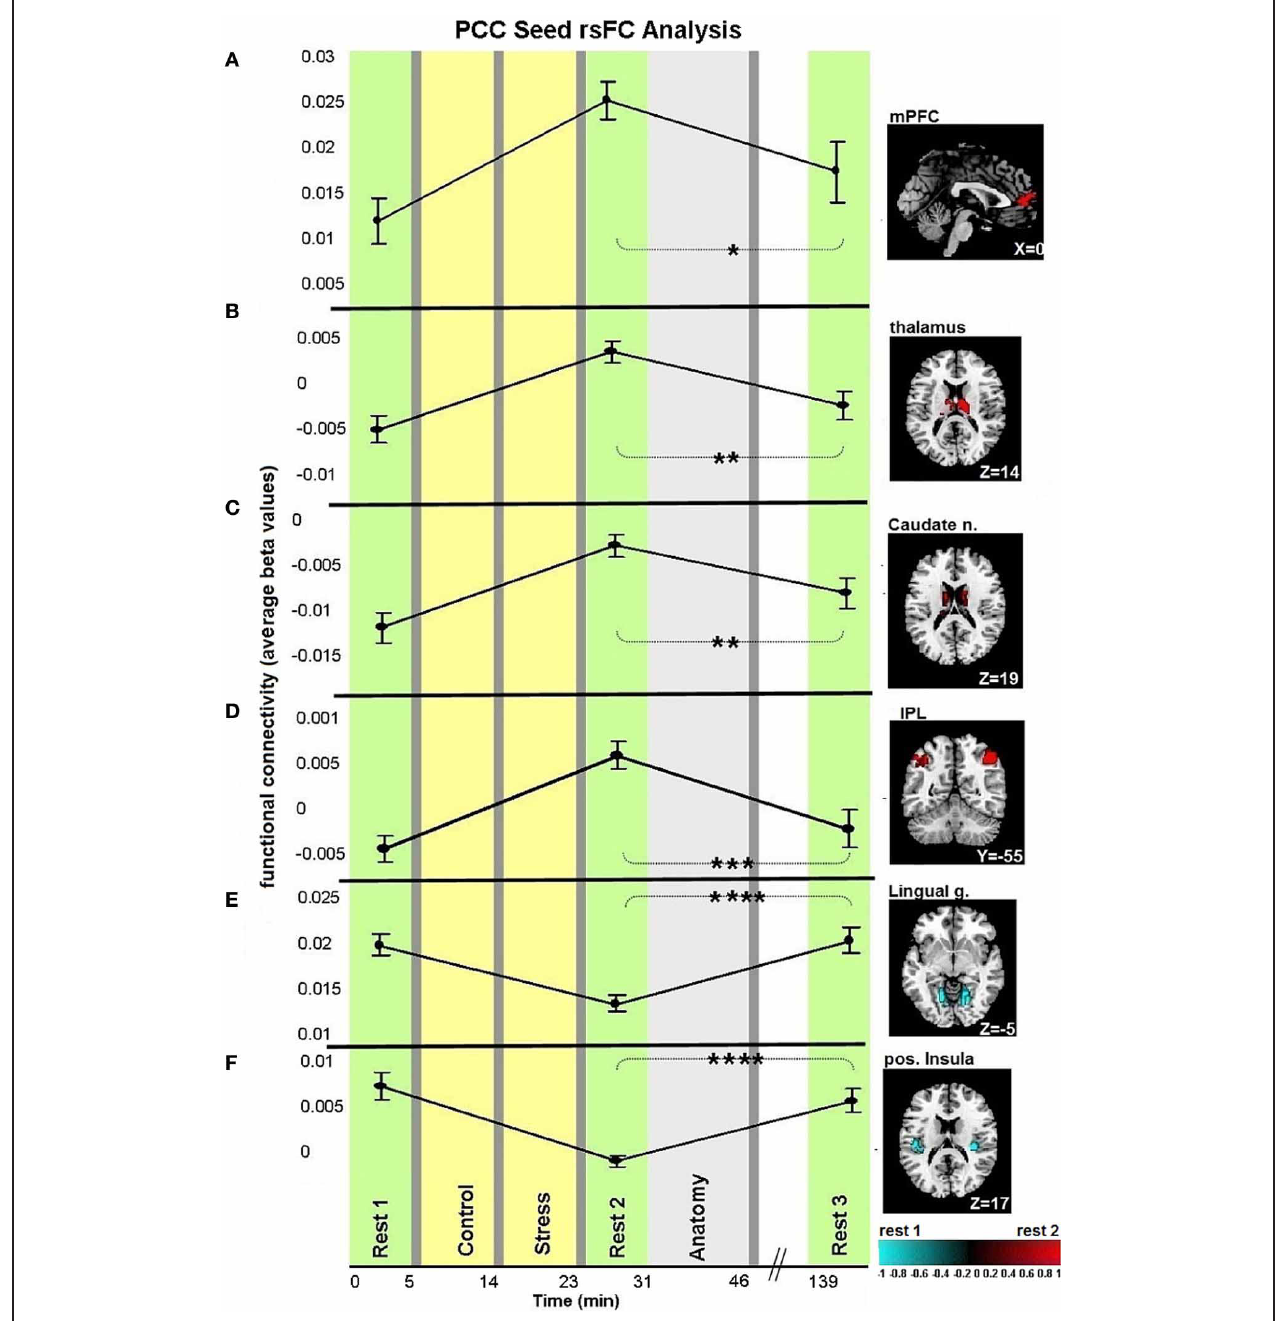
FIGURE 3 | Dynamics in rsFC to the PCC seed ROI in the three “rest” conditions. Localized areas that changed connectivity to the PCC seed (A–F) when contrasting “rest 1” and “rest 2” are presented on the right hand side. rsFC at “rest 1,” “rest 2,” and “rest 3” are presented in reference to the